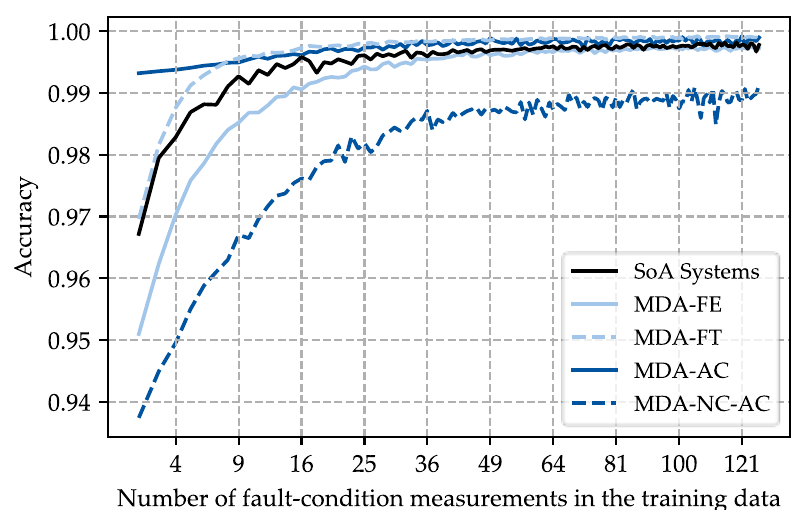
Figure 16. Learning curves of the state-of-the-art diagnostic systems.